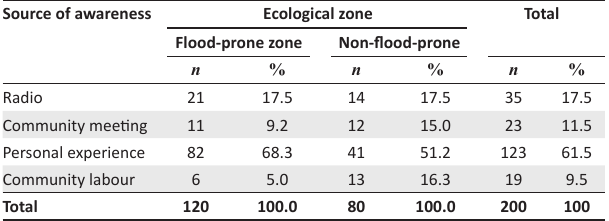
TABLE 1: Source of flood disaster awareness among residents of